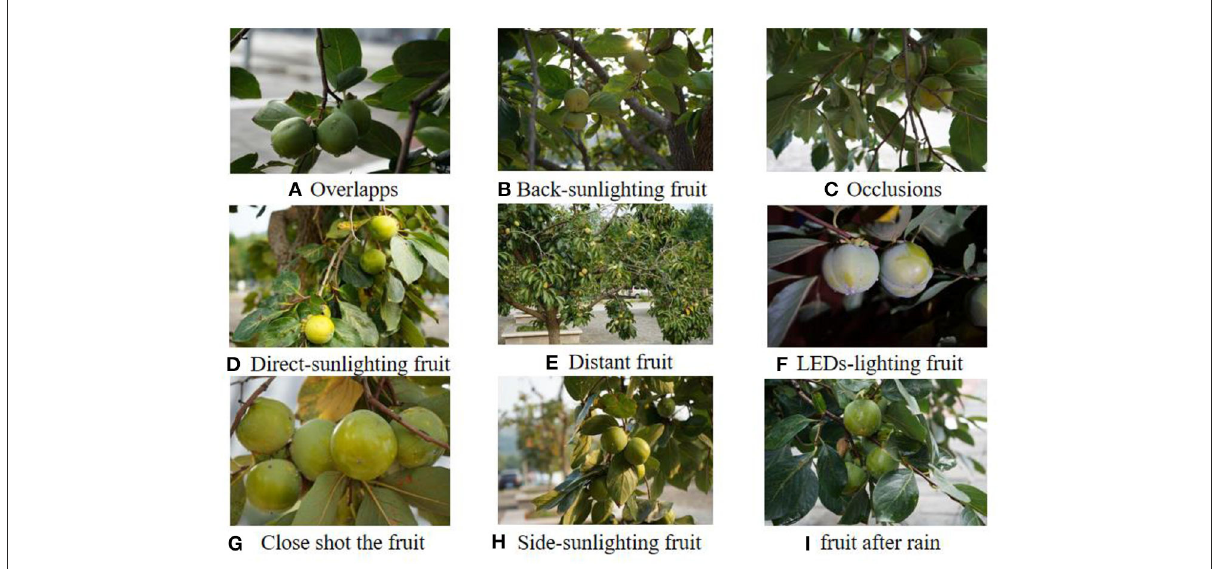
FIGURE1 Green persimmon fruit images under different complex orchard environments. (A) Overlapps, (B) Back-sunlighting fruit, (C) Occlusions, (D) Direct-sunlighting fruit, (E) Distant fruit, (F) LEDs-lighting fruit, (G) Close shot the fruit, (H) Side- Back-sunlighting fruit, (I) Fruit after rain.